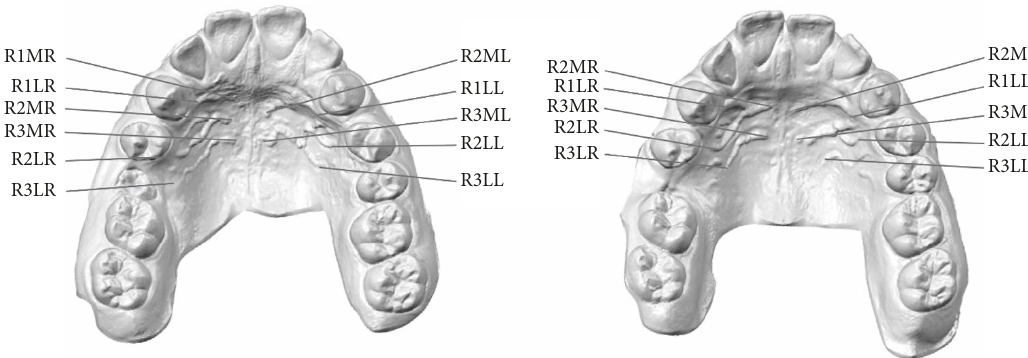
Figure 3: Maxillary occlusal digital models of the identical twins with the selected medial and lateral points of the palatal rugae.